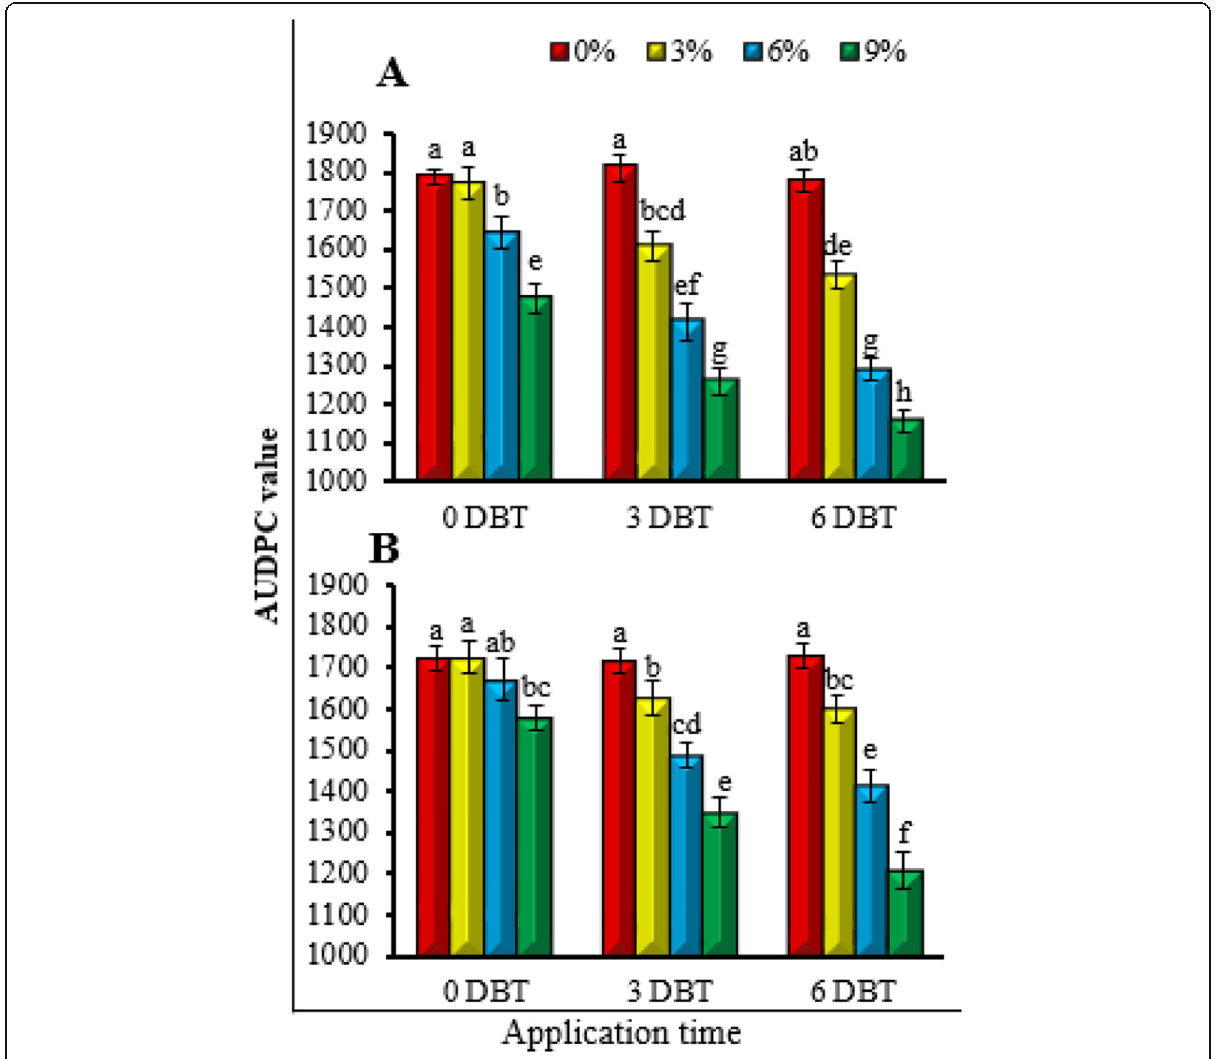
Fig. 3 Effect of fungal metabolites on AUDPC values of bacterial wilt in tomato plants inoculated with R. solanacearum . Each value is a mean ± SD. Treatments having significant differences on the basis of LSD test have different lettering. a Experiment I. b Experiment II. Both experiments I and II are the same repeated experiments without any modification. DBT, days before